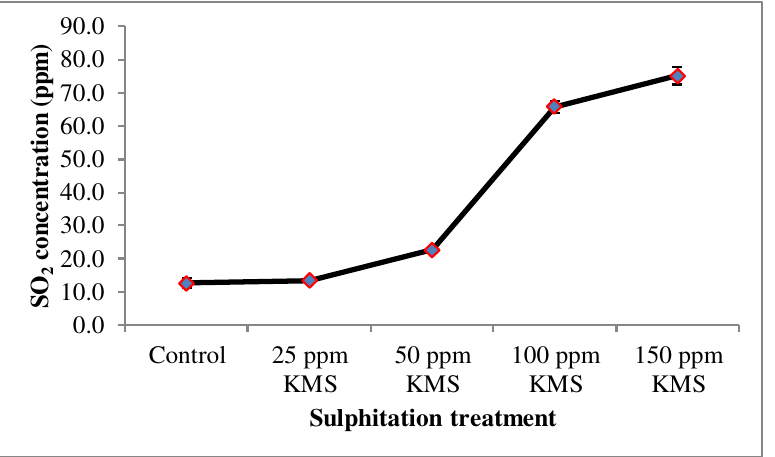
Figure 5. Effect of sulphitation on the SO 2 concentration during refrigerator storage (the numerical mean and the error bars (S.E) of triplicates (n = 3) are displayed in the line graph).